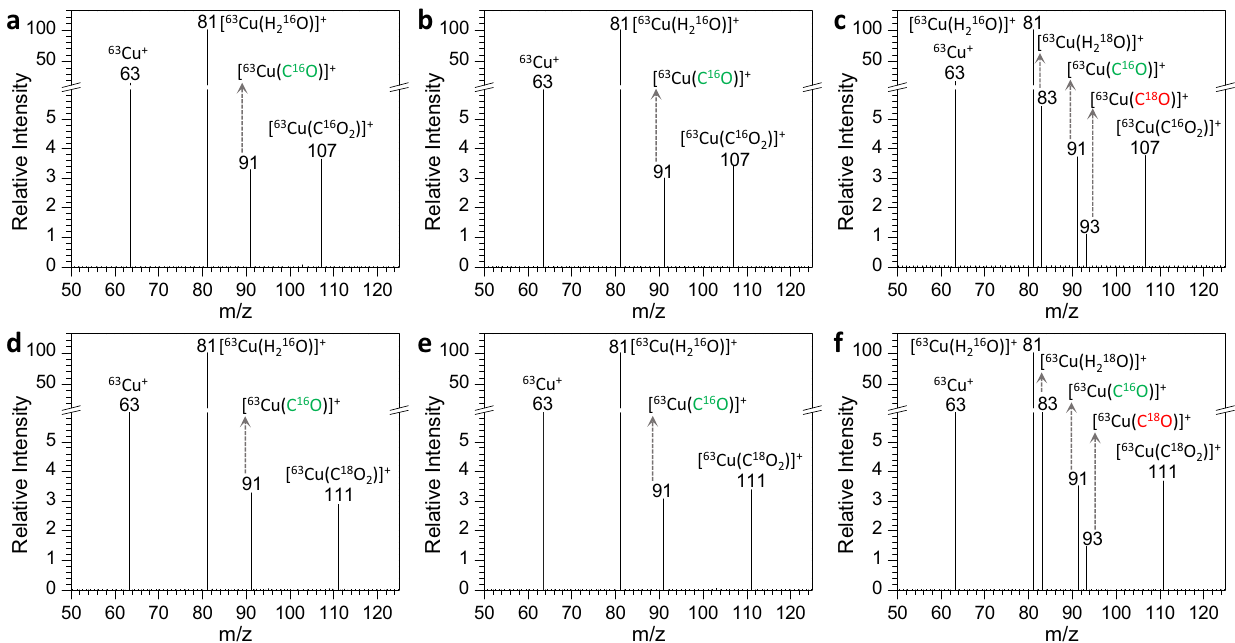
Fig. 4 Isotope-labeling MS measurement results under different systems. a [ 63 Cu(H 2 16 O)] + and C 16 O 2 . b [ 63 Cu(H 2 16 O)] + , H 2 16 O, and C 16 O 2 . c [ 63 Cu(H 2 16 O)] + , H 2 18 O, and C 16 O 2 . d [ 63 Cu(H 2 16 O)] + and C 18 O 2 . e [ 63 Cu(H 2 16 O)] + . H 2 16 O, and C 18 O 2 ; f [ 63 Cu(H 2 16 O)] + , H 2 18 O and C 18 O 2 (gas circuit temperature: 280 o C; reaction pressure: 1.5